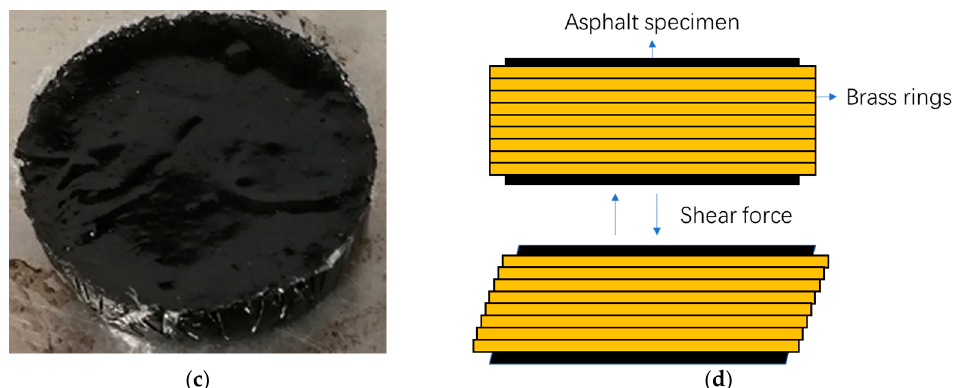
Figure 1. Test instrument: ( a ) cyclic simple shear instrument; ( b ) illustration of the instrument; ( c ) asphalt specimen; ( d ) illustration of the cyclic shear.